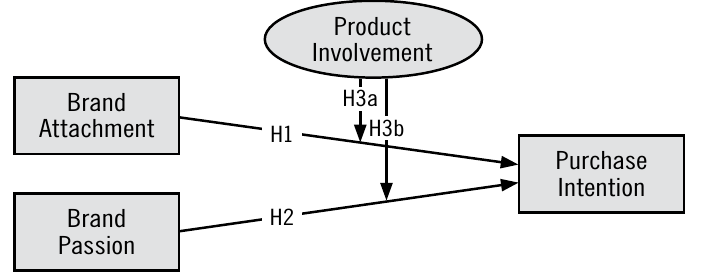
Figure 1. Proposed theoretical